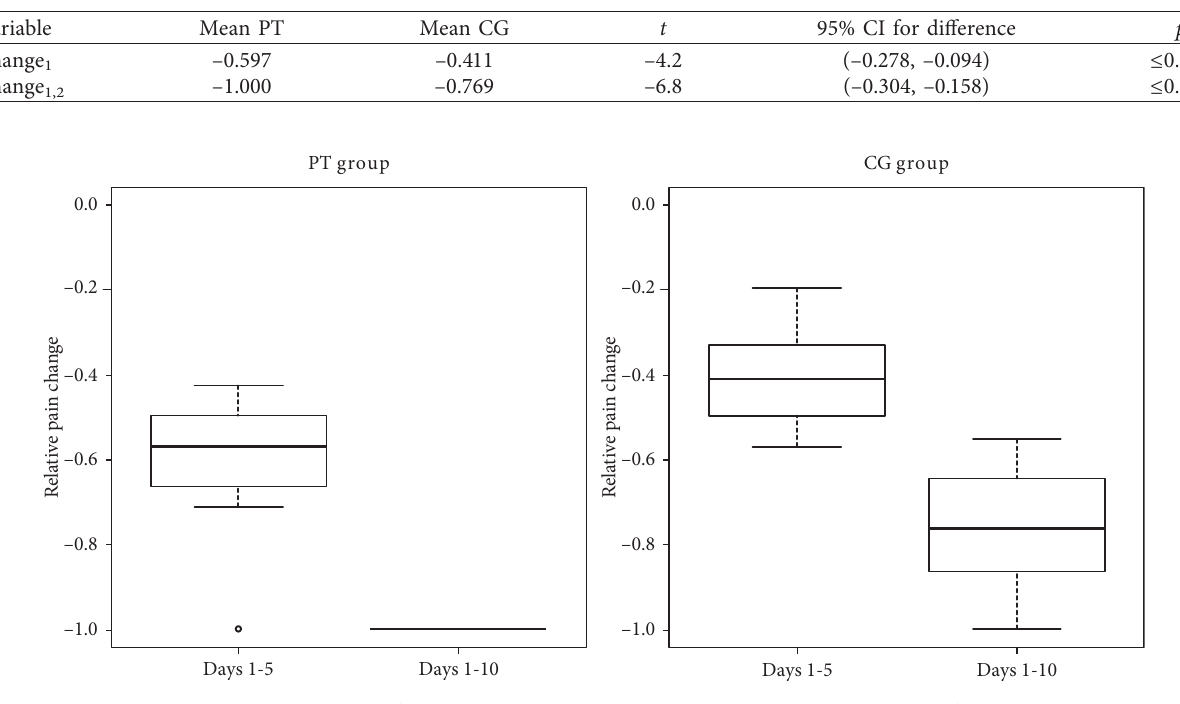
Table 4: Significance of differences in mean changes in pain intensity between groups.